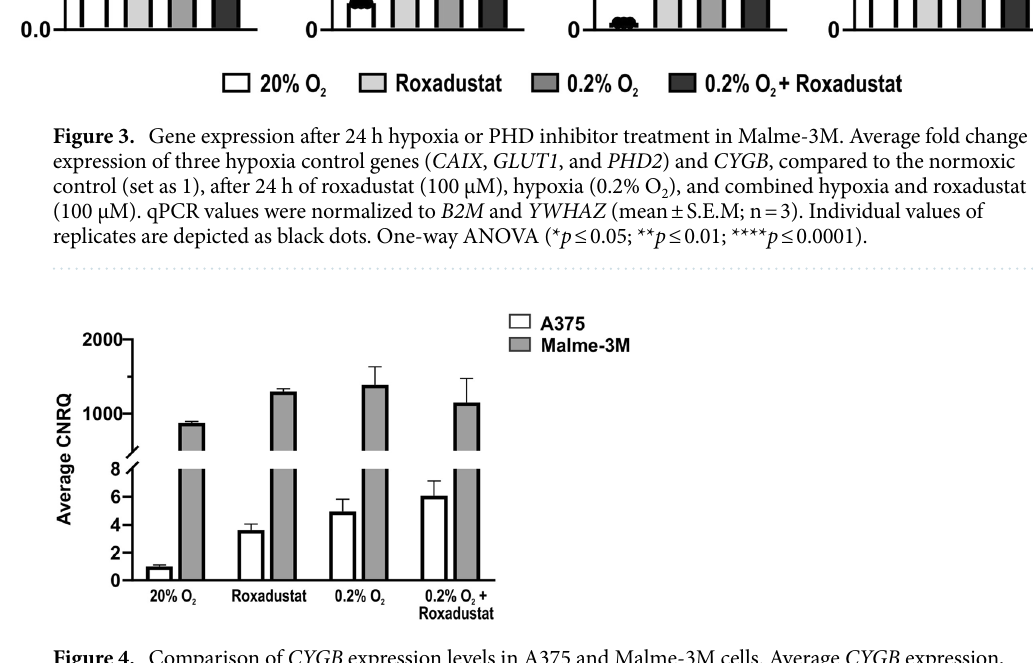
Figure 4. Comparison of CYGB expression levels in A375 and Malme-3M cells. Average CYGB expression, compared to the normoxic A375 control (set as 1), after 24 h of roxadustat (100 µM), hypoxia (0.2% O 2 ), and hypoxia and roxadustat (100 µM). qPCR values were normalized to B2M and YWHAZ (mean ± S.E.M; n = 3). Calibrated normalized relative quantities (CNRQ) represent the relative quantity between different samples for a given target gene (i.e. CYGB ) 52